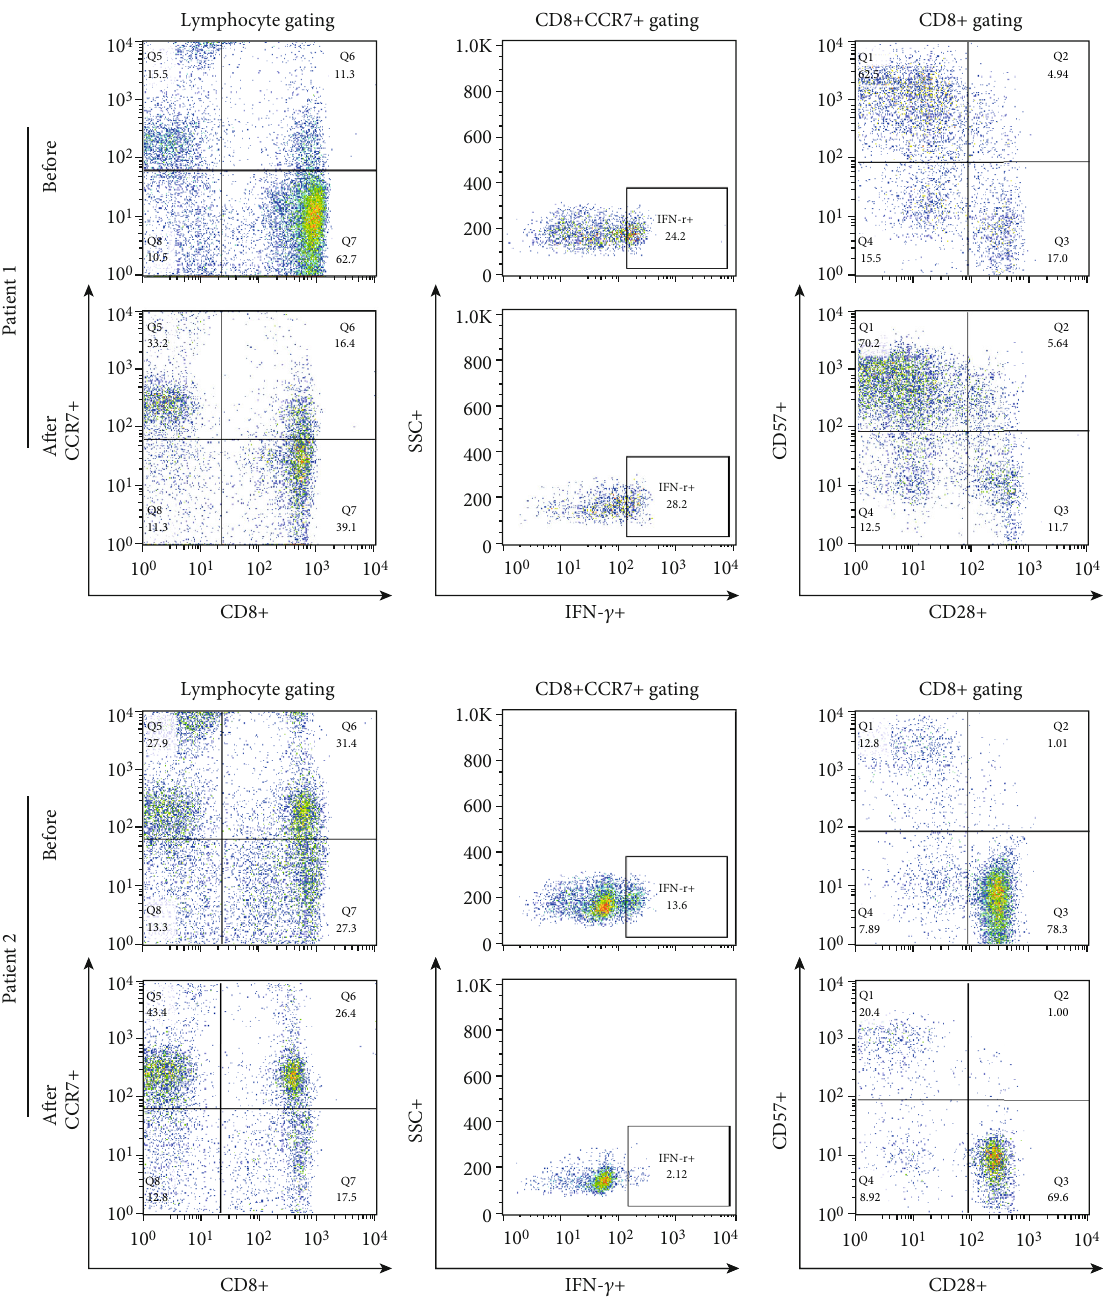
Figure 6: Comparison of CCR7+CD8+ and e ff ector T cells before and after MSC treatment. PBMCs were stained with anti-CD8 APC- conjugated, anti-CCR7 streptavidin Cy5.5-conjugated, anti-IFN- γ FITC-conjugated, anti-CD28 PE-conjugated, and anti-CD57 FITC- conjugated antibodies. The representative fi gure for the fl ow cytometric analysis of CCR7+ CD8+/lymphocytes and CD28-CD57+/CD8+ T cells is shown. “ Before ” indicates the results at the start of MSC treatment, and “ After ” indicates the results at 3 months after the fi nal MSC infusion. MSCs: mesenchymal stem cells; PBMCs: peripheral blood mononuclear